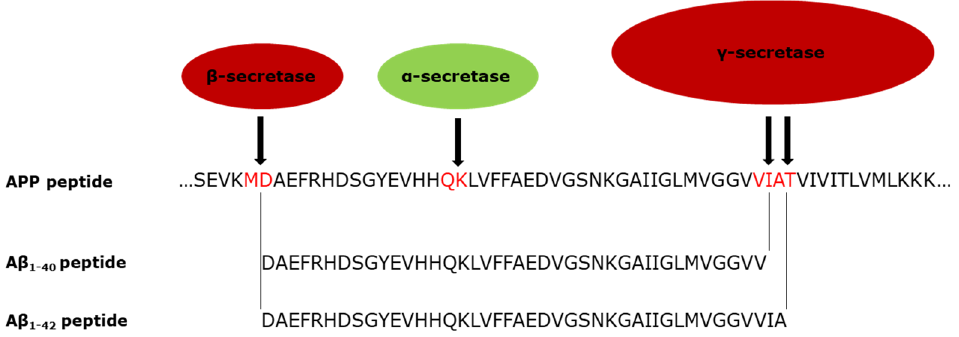
Figure 1. Cleavage of APP by beta and gamma secretase (in red) to release the A β 1–40 and A β 1–42 peptides associated with AD, and showing the alternative cleavage position of alpha secretase (green) [17,19].